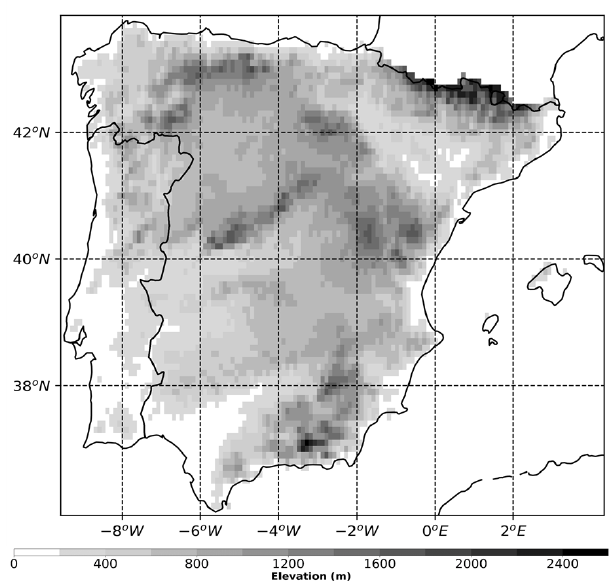
Figure 1. Orography from the Iberian Gridded Dataset for the Iberian Peninsula at 0.1 ◦ horizontal